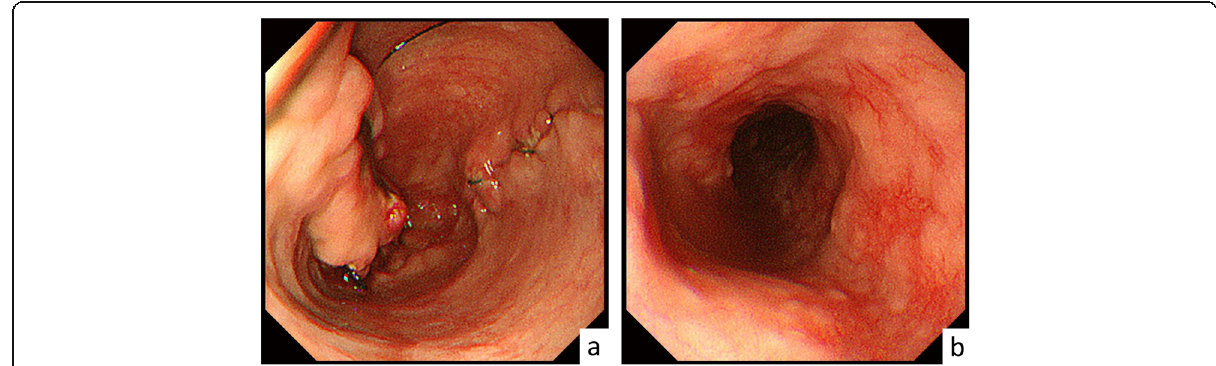
Fig. 4 Upper endoscopy 8 days after the operation. a Anastomotic ulcer. b Reflux